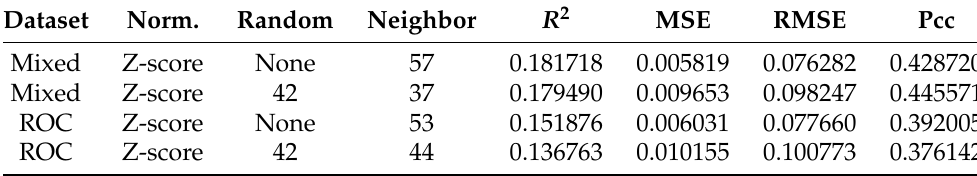
Table 1. Top 2 best metric performers in KNN